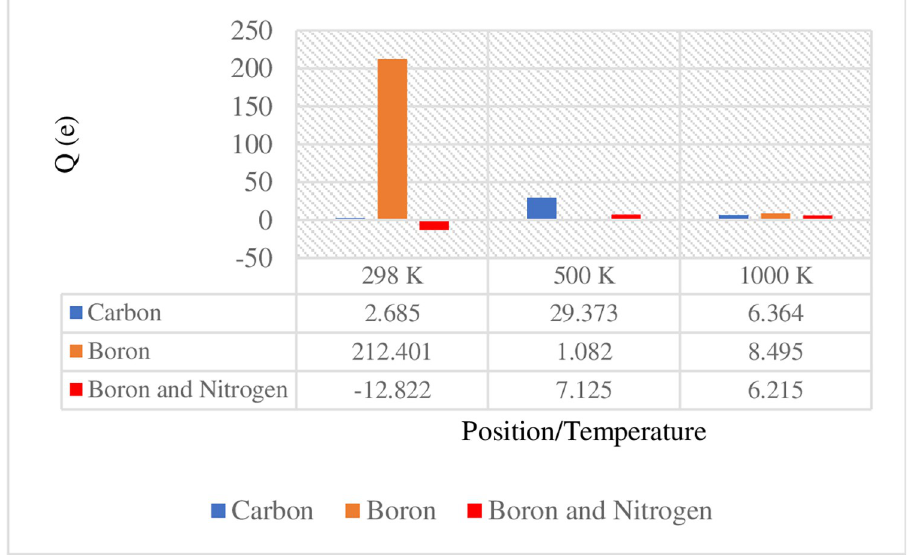
Fig 12. Comparison of the charge transfer for 12-BC 2 NNR at three different